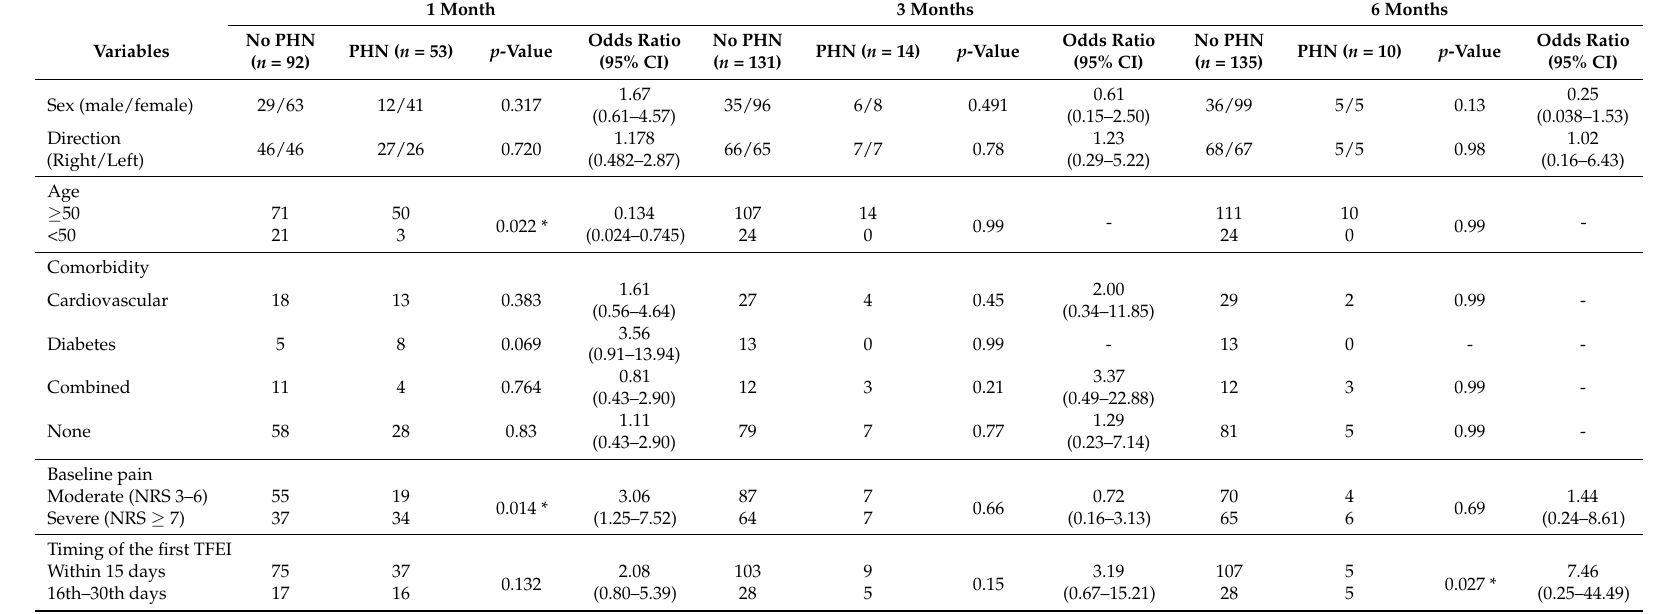
Table 2. Univariate analysis of PHN vs. non-PHN at 1 month, 3 months, and 6 months after the